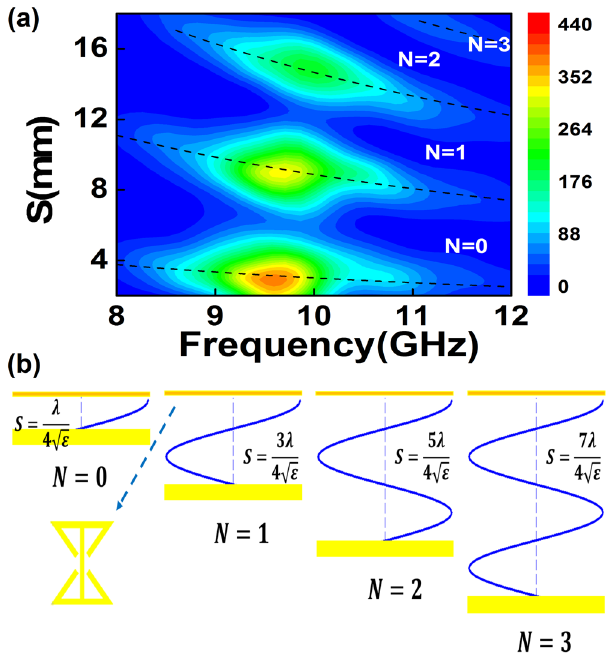
Figure 4. FP-like mode and visual theory. ( a ) Plot of the PV as a function of microwave frequency (8–12 GHz) and cavity thickness (2–18 mm). ( b ) The thickness ( S ) of the cavity corresponding to the orders ( N ) of the cavity mode in our photonic-like resonant